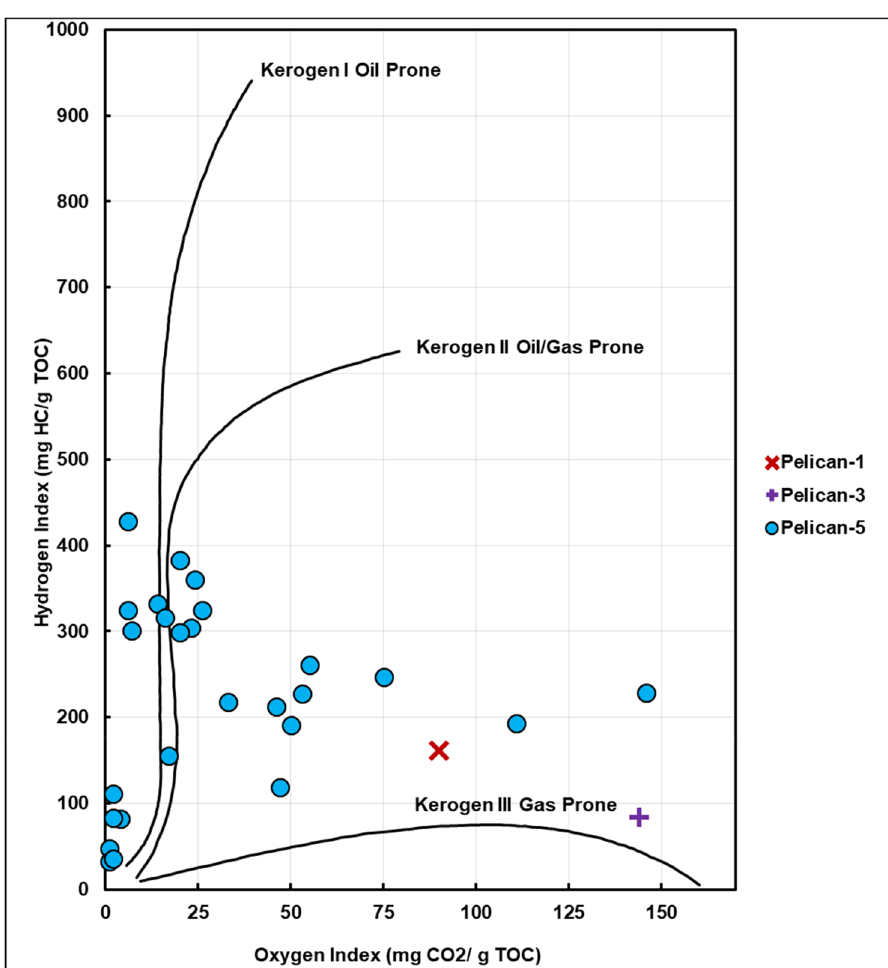
Fig. 8 Modified Van Krevelen diagram (HI versus OI) for determining the type of kerogen present in the source rock (Espi- talié et al.